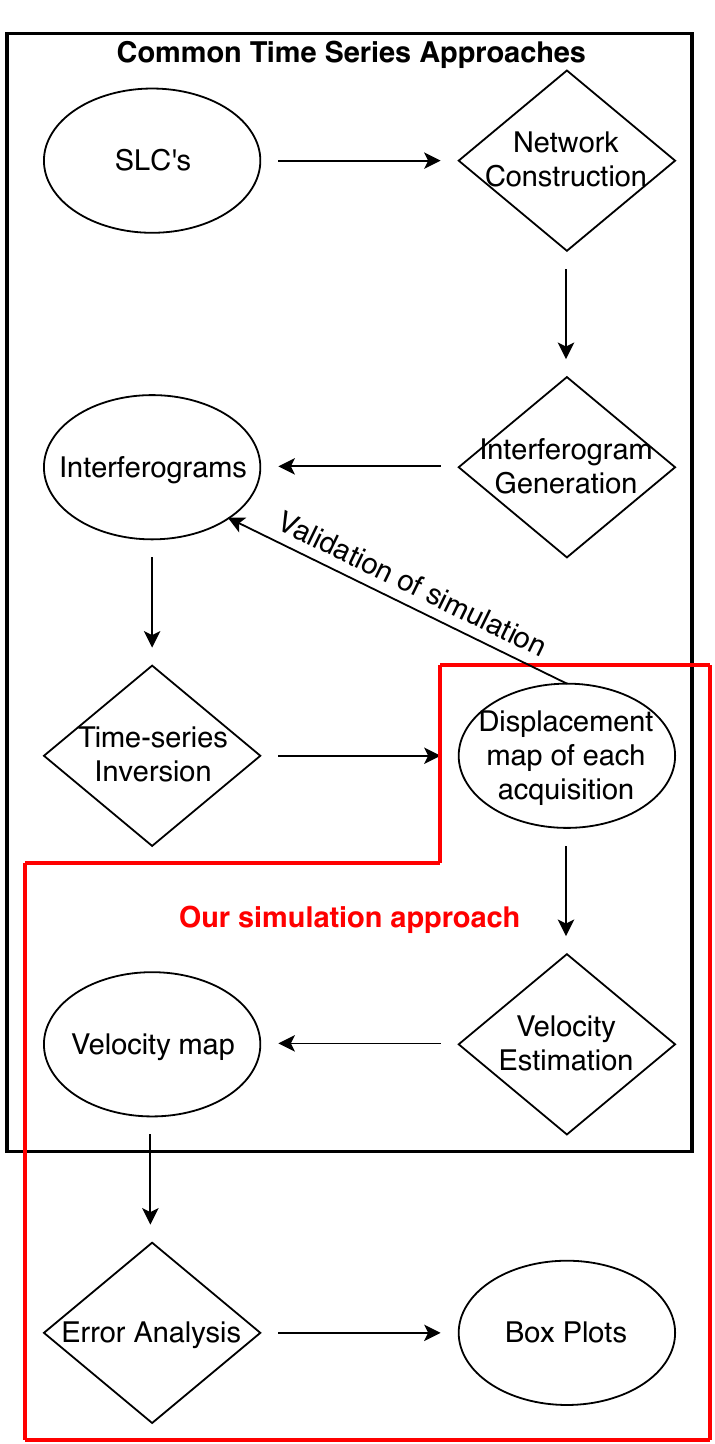
Figure 2. Flow chart showing the standard InSAR time-series process and our simulation method (outlined with red): the diamonds represent processing stages, and the ellipses represent